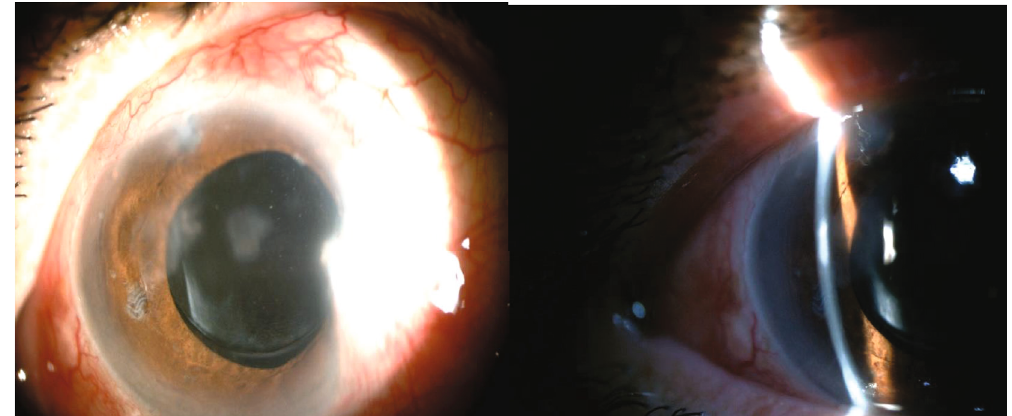
Figure 2: Slit lamp photograph of the same eye after argon laser synechiolysis showing symmetric deep anterior